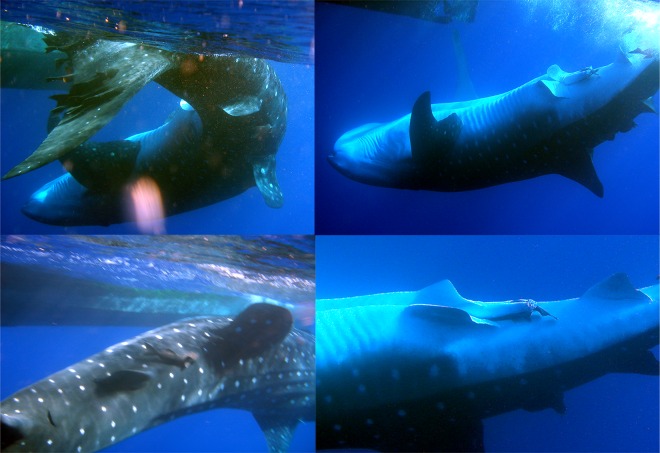
Male potential courtship behaviour.Multiple rolling behaviour by a large male R. typus displayed with the fishing vessel and close up of its clasper abrasion recorded in the ASPSP. Credit: Sibele Mendonça©.